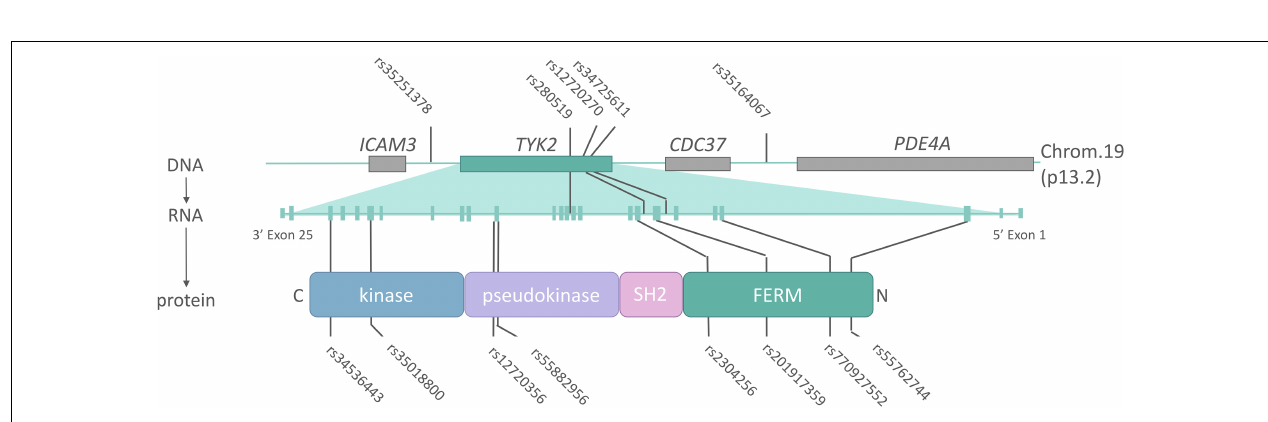
FIGURE 2 | Role of TYK2 in IL-23 receptor signaling. (A) Inactive JAK2/TYK2 associate with the intracellular domain of their respective cytokine receptor subunits in the steady-state through FERM and SH2 domains. JAK inactivity is mediated in part by pseudokinase domain inhibition of the kinase domain. The binding of IL-23 unites its respective cytokine receptor subunits, which in turn causes a conformational change in JAK2/TYK2, allowing for their kinase activity. Phosphorylation of JAKs and the intracellular domain of the cytokine receptors allows for the recruitment and activation of the STAT3 transcription factor and subsequent induction of gene expression. Inducible inhibition of IL-23 is mediated in part by the SOCS family of proteins, which can bind to JAKs to block their cytokine activity, and can tag JAKs for ubiquitin mediated degradation. While not specifically researched in the context of IL-23R, constitutive inhibition of JAKs is mediated by phosphatases such as SHP1 and CD45. (B) Selected TYK2-associated cytokines, their receptor subunits and associated intracellular signaling molecules. The dominant STAT activated by the respective cytokine is indicated, but STAT usage can be cell- and context-dependent.